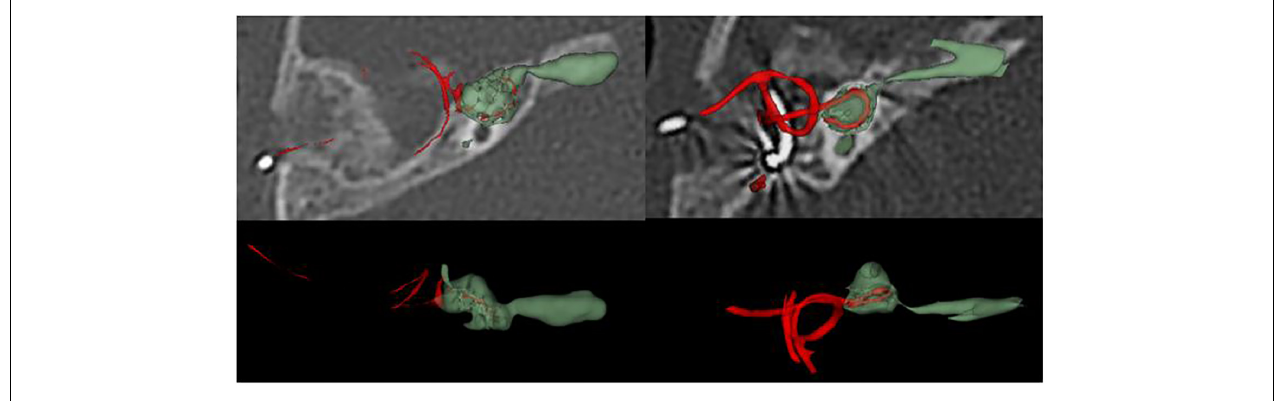
FIGURE 2 | Computed tomography (CT) reconstruction of surgical side in patients with common cavity deformity (CCD). activation. Similar results were reported by Xia et al.